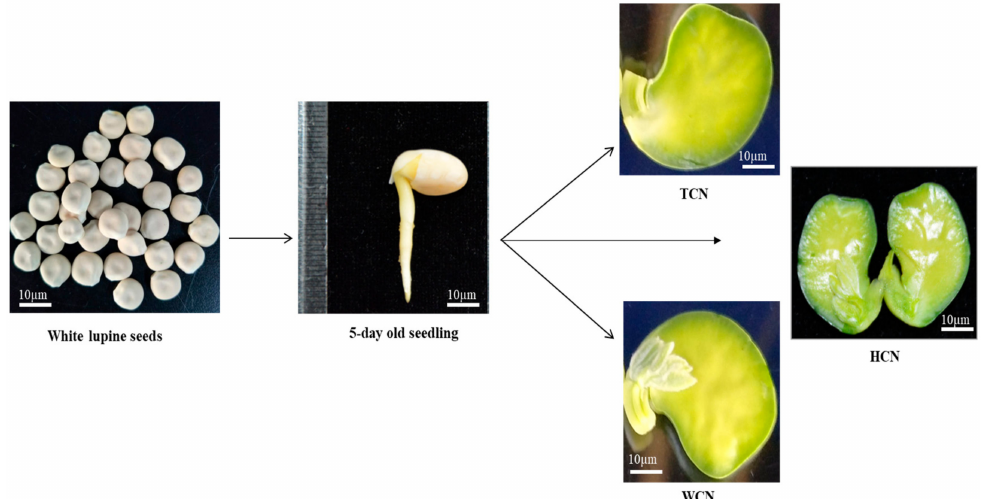
Figure 1. Preparation of explants from 5 day old seedlings of Lupinus albus . TCN (traditional cotyledonary node), HCN (half cotyledonary node), and WCN (whole cotyledonary node).